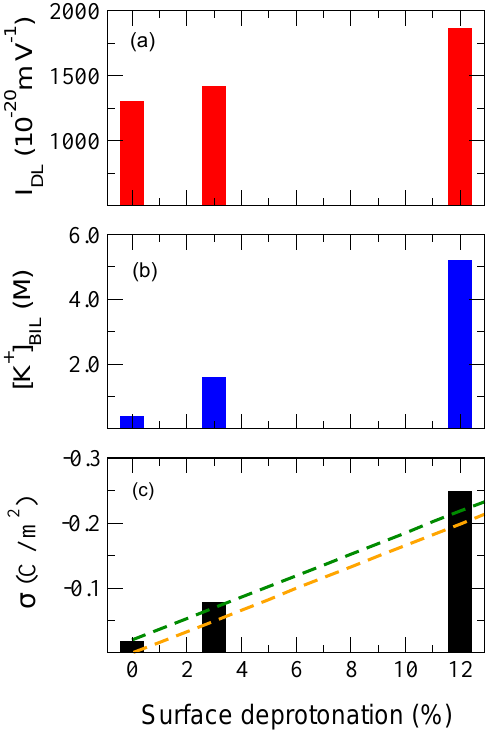
Figure 4. ( a ) I DL values obtained for (0001) α -quartz–water interfaces with an increasing degree of surface deprotonation (dehydroxylation). ( b ) Excess [K + ] concentration in the BIL needed to bring the QW interfaces at the isoelectric point. ( c ) Surface charge, σ , calculated from the simulated Sum Frequency Generation (SFG) spectra of the QW interfaces at increasing surface deprotonation/dehydroxylation and compared to previous extimations from ref. [34] (orange dashed line) and to the values obtained form ref [34] once correcting for the negative contribution of SiOH to the surface charge (dashed green line, see discussion in the